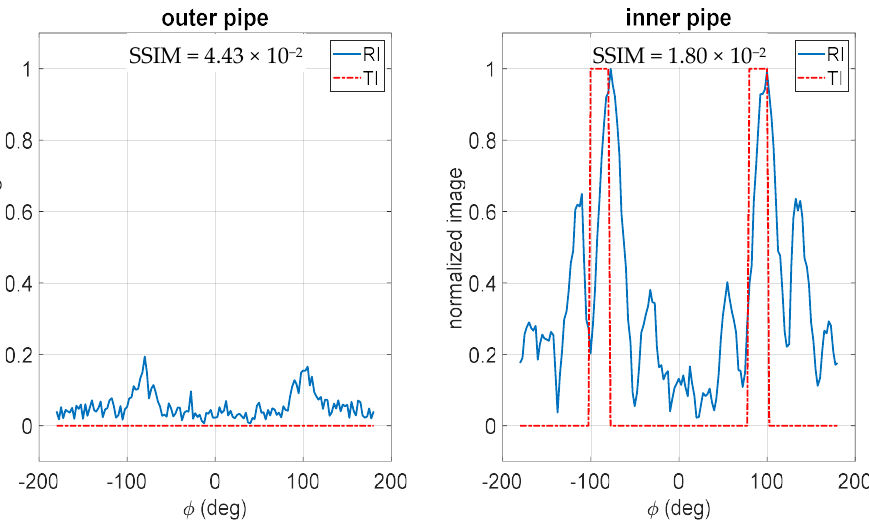
Figure 5. Reconstructed images of the reference case using single frequency data (RI: reconstructed image and TI: true image).